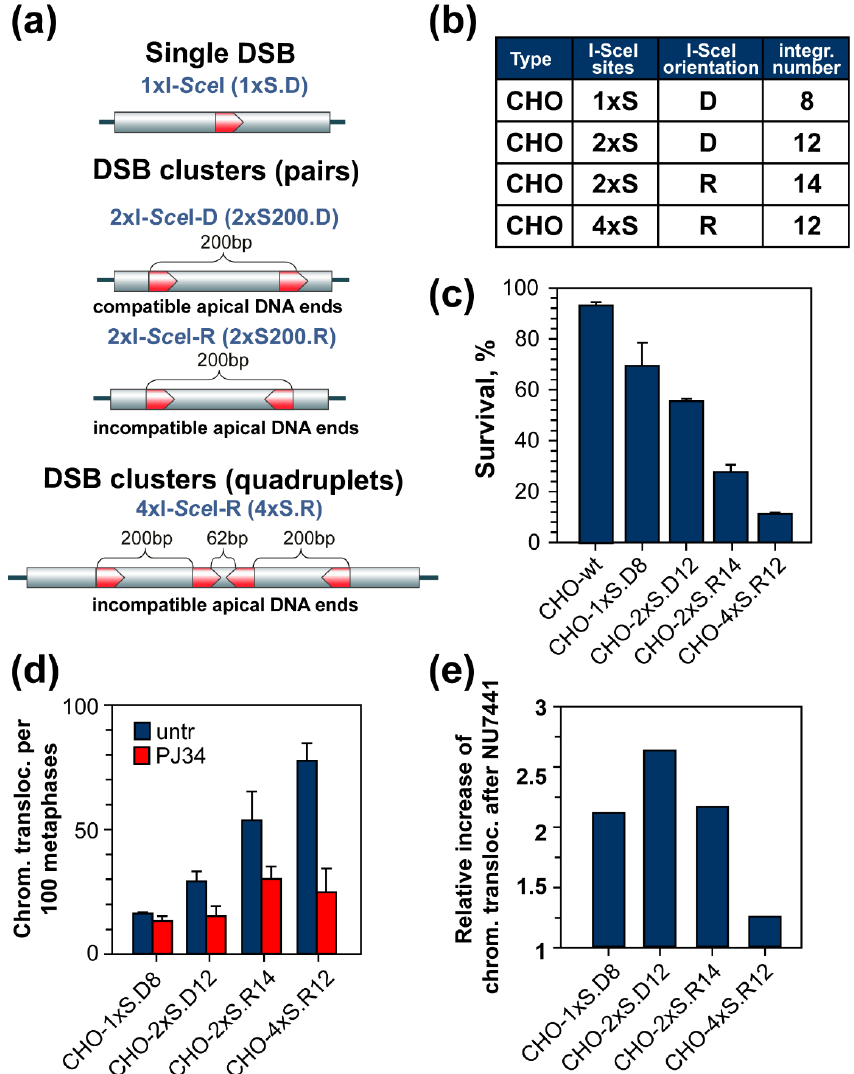
Figure 6. A model system to study the biological consequences of defined DSB clusters in Chinese Hamster Ovary (CHO) cells using engineered clusters of I-SceI recognition sequences. ( a ) Schematic representation of I-SceI constructs containing single DSBs, DSB pairs, and DSB quadruplets and integrated multiple times in the genome of CHO cells. ( b ) Description of the cell lines generated explaining the nomenclature used. The number of I-SceI sites (1x, 2x, 4x), their orientation (direct-D, reverse-R), and the number of integrations is presented in the table. ( c ) Clonogenic survival experiments of CHO cells harboring DSB clusters of different complexity. ( d ) Translocations forming in the same cell lines when analyzed at metaphase without any treatment, or after treatment with the PARP-1 inhibitor, PJ34. ( e ) Relative increase in chromosomal translocations after inhibition of c-NHEJ by incubating with the DNA-PKcs inhibitor NU7441. The results shown have been published and are redrawn here to illustrate the concepts developed in the review